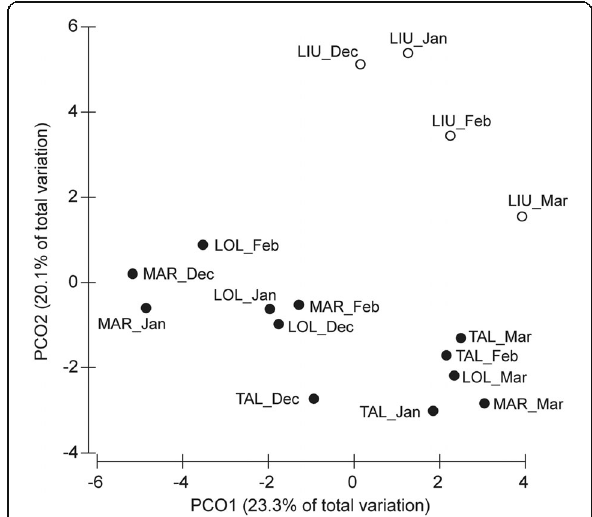
Fig. 3 Principal Coordinate Analysis (PCoA) based on relative abundance of the phytobenthos community for the studied months and sites (white circle=site not invaded by D. geminata ; black circle=sites invaded by D. geminata )